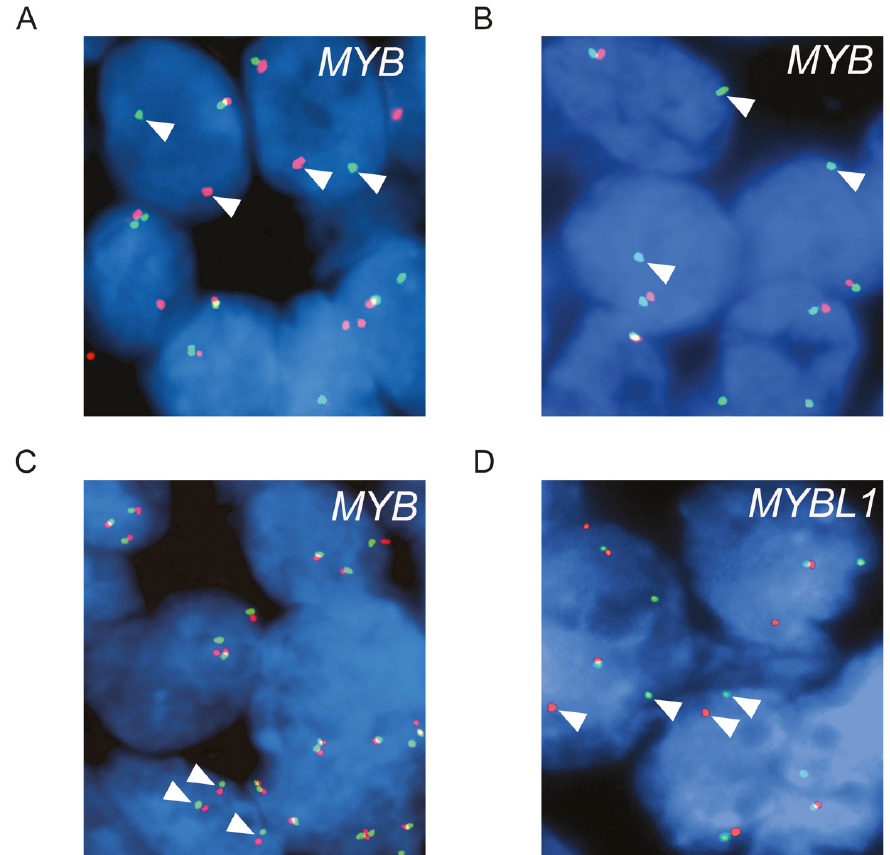
Figure 1. FISH analyses of MYB and MYBL1 in ACC. ( A ) ACC with a split MYB signal (separated red and green signals indicated by arrowheads). ( B ) ACC with loss of the 3 ′ -part of MYB (loss of one red signal; arrowheads indicate the remaining green signal). ( C ) ACC with gain of one copy of MYB (three fused red/green signals indicated by arrowheads). ( D ) ACC with a split MYBL1 signal (separated red and green signals indicated by arrowheads). Images were captured using an 100 × objective. Alterations of the MYBL1 locus were found in 16% (28/175) of the ACCs (Figure 1 D and Figure 2). Split signals indicating translocation of MYBL1 were detected in 7.4% (13/175), gain of one apparently intact MYBL1 allele in 4.6% (8 of 175), and loss of one MYBL1 allele in 4% (7/175) (Figure 1D). All tumors with rearrangements of MYBL1 were MYB negative by FISH.